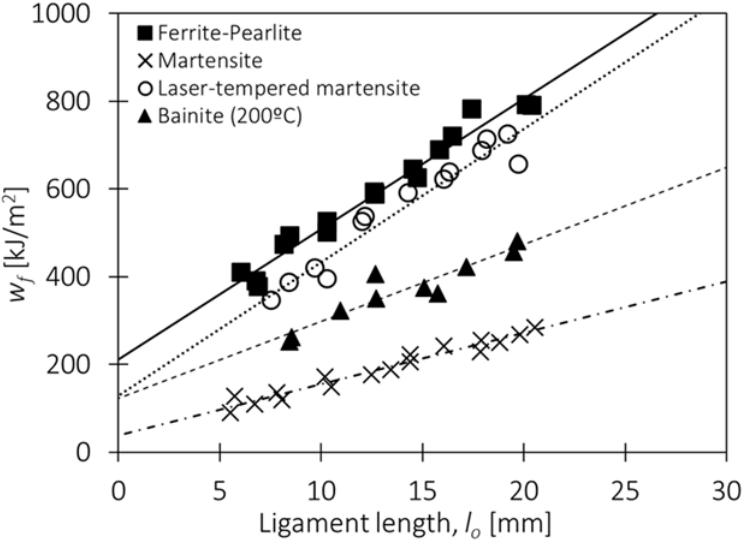
Figure 9. w f as a function of the ligament length, l o and linear data regression obtained for the different microstructures.